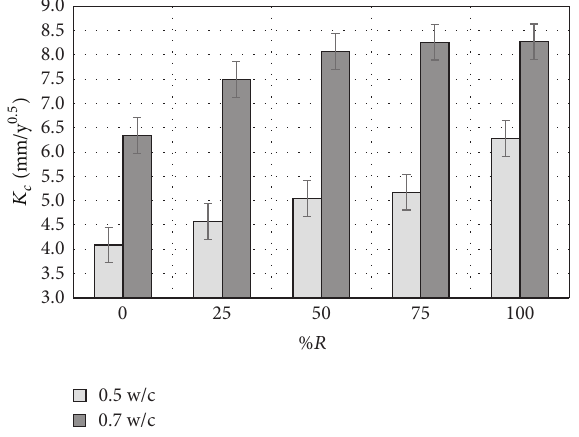
Figure 4: Carbonation versus % 𝑅